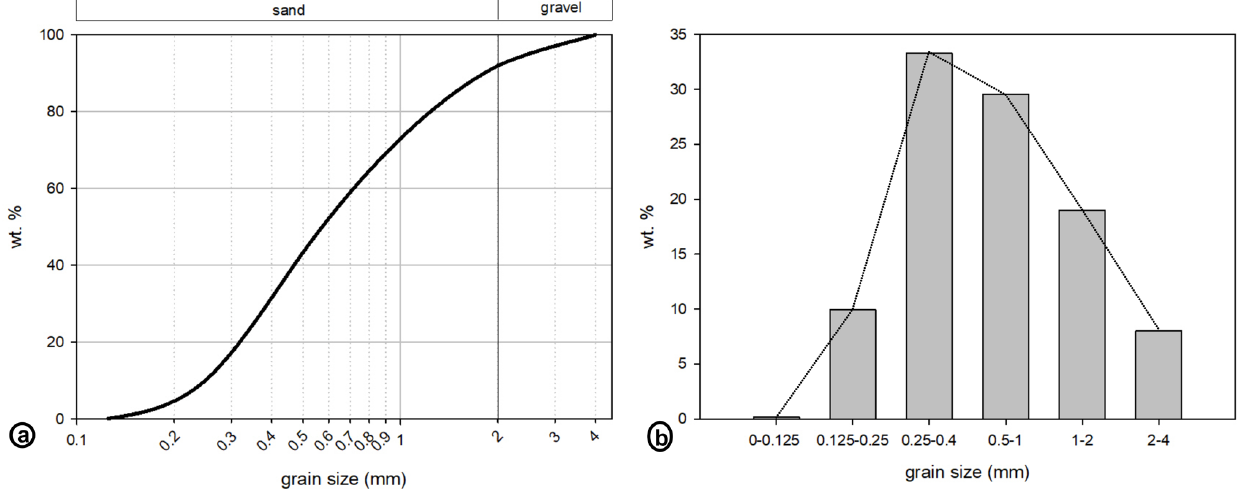
Figure 1. ( a ) Cumulative grain - size curve (Fuller grain - size distribution) of the aggregates used to produce recycled mortars. ( b ) Grain sizes by